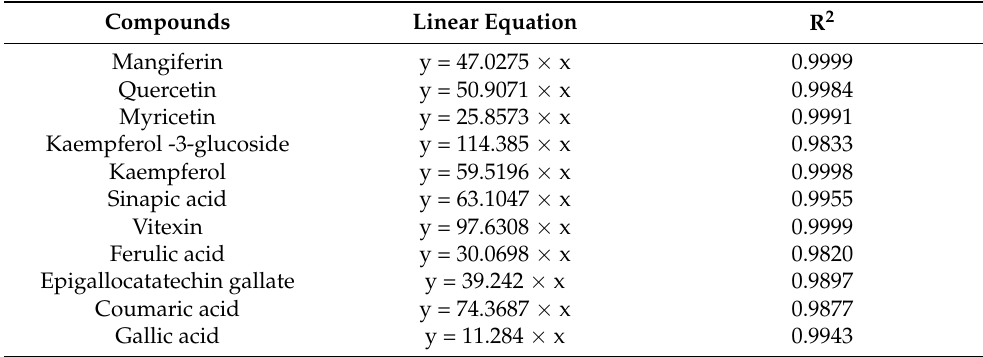
Table 2. The analytical characteristic for determination of myrtle leaf